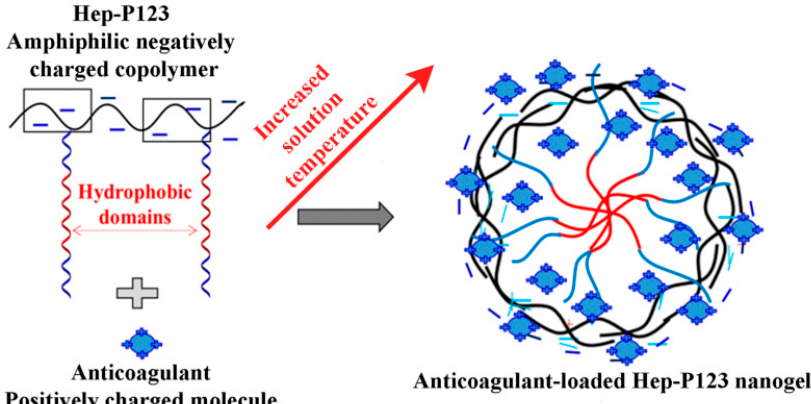
Figure 4. Illustrated mechanism for formation of Ado or IW-loaded Hep-P123 nanogels.